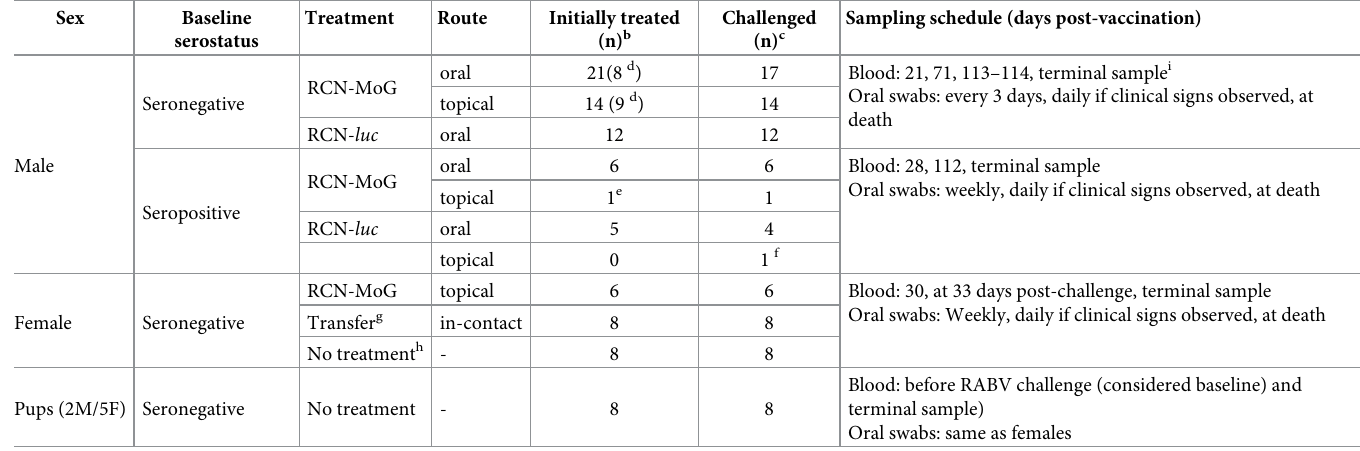
Table 1. Experimental setup of common vampire bats grouped by sex, rabies virus neutralizing antibodies serostatus at baseline time point, treatment, and route. Males received 1x10 8 PFU/mL orally of RCN-MoG (vaccine) or RCN- luc (control), or 2x10 8 PFU/mL of RCN-MoG mixed in 0.5 mL of glycerin jelly for topical vaccine. Topically vaccinated females received 5x10 8 PFU/mL RCN-MoG in 1 mL a . Eight captive-born pups did not receive treatment but were included in the RABV challenge. For this group F = female and M = male, one pup was not sexed. The sampling schedule differed for male and female and seropositive groups, as indicated in the last